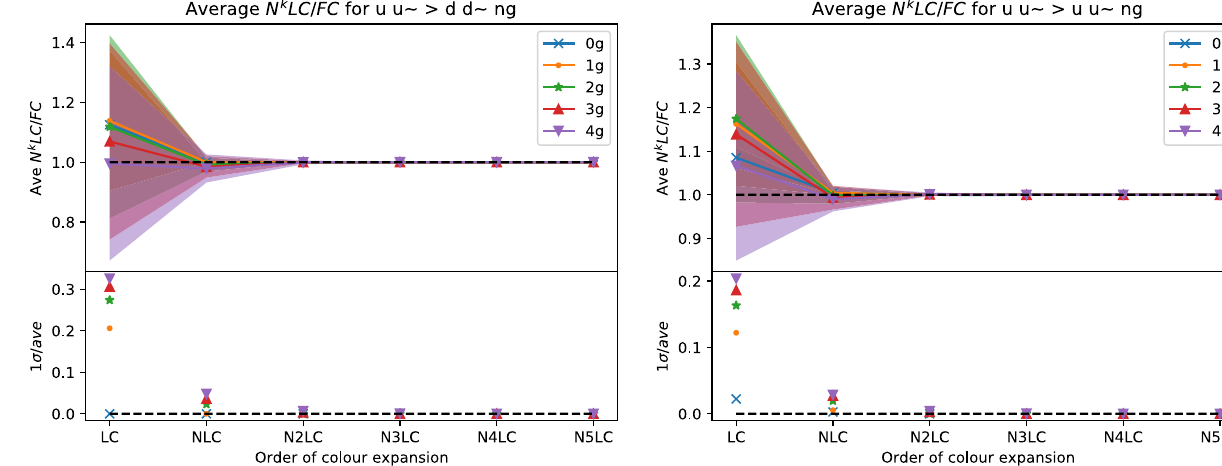
Fig. 5 Same as Fig. 3 but for the processes u ¯ u → d ¯ d + ng and u ¯ u → u ¯ u + ng